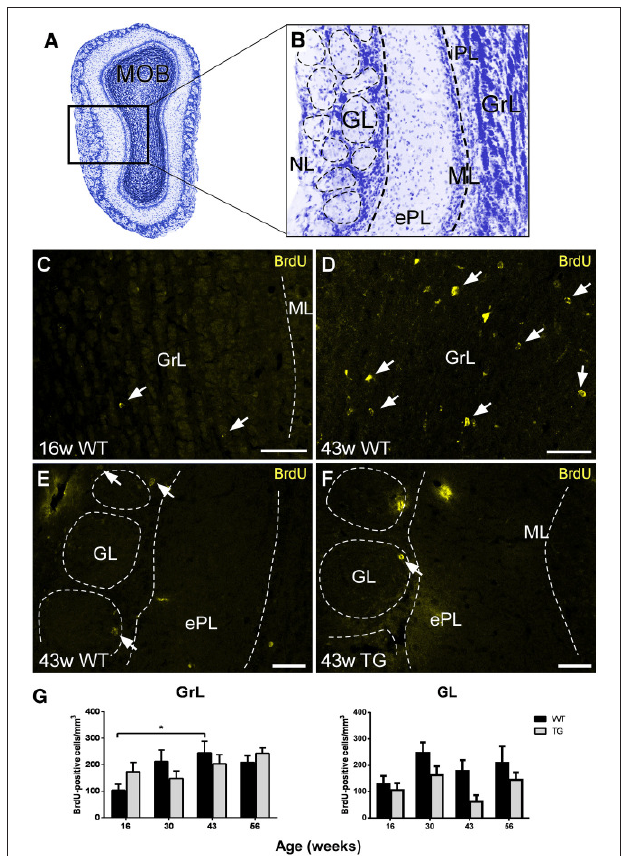
FIGURE 2 | Analysis of neurodegeneration in the olfactory bulb by quantification of NeuN- and PGP9.5-labeled cells. Confocal images showing NeuN-positive (A,B,E,F) and PGP9.5-positive cells (C,D) counterstained with DAPI. (G) , graphics illustrating the estimation of NeuN- and PGP9.5-positive cells/mm 3 in control and transgenic animals in the different layers with aging. Calibration bar, 50 µ m. and transgenic animals ( Figures 5A–F ). In the GrL/iPL of transgenic animals, the expression significantly increased from 30 ( Figure 5A ) to 56 ( Figure 5B ) weeks ( Figure 5G ) [Two- way ANOVA (genotype vs. age): Interaction F (3 , 28) = 3.334; p = 0.0336; Age F (3 , 28) = 1.875; p = 0.1568; Genotype F (1 , 28) = 1.481; p = 0.2338]. At 30 weeks, the expression in control animals was higher as compared to transgenic animals [ T -test two tailed control vs. transgenic: t 7 = 2.873; p = 0.0239]. In the ML/ePL of control animals, the expression significantly decreased from 16 ( Figure 5C ) to 30, 43, and 56 ( Figure 5E ) weeks ( Figure 5G ); and, at 16 weeks, the expression in control animals ( Figure 5C ) was higher as compared to transgenic ( Figure 5D ) animals ( Figure 5F ) [Two-way ANOVA (genotype vs. age): Interaction F (3 , 28) = 3.208; p = 0.0382; Age F (3 , 28) = 6.341; p = 0.0020; Genotype F (1 , 28) = 2.021; p = 0.1662] [ T -test two tailed control vs. transgenic: p > 0.05]. In the GL/NL, no significant changes with aging or genotype were detected ( Figures 5A–G ) [Two- way ANOVA (genotype vs. age): Interaction F (3 , 28) = 1.031; p = 0.3940; Age F (3 , 28) = 0.7346; p = 0.5402; Genotype F (1 , 28) = 0.1791; p =